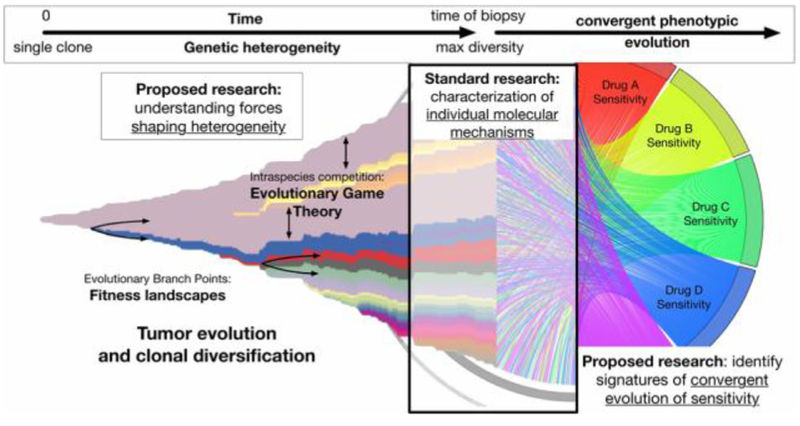
Correspondence of research strategies to the process of tumour evolution: Tumour heterogeneity is driven by clonal populations traversing evolutionary trajectories, the interactions between them, and the diversification that results. The milieu of molecular mechanisms that can be observed at the time of biopsy potentially confers finite drug sensitivity phenotypes.